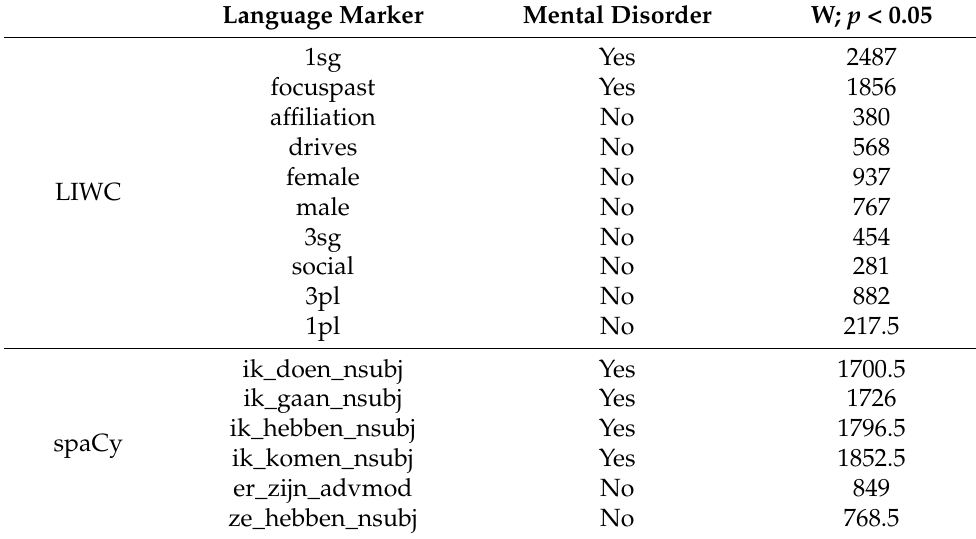
Table 6. Summary of language markers uncovered by LIWC and